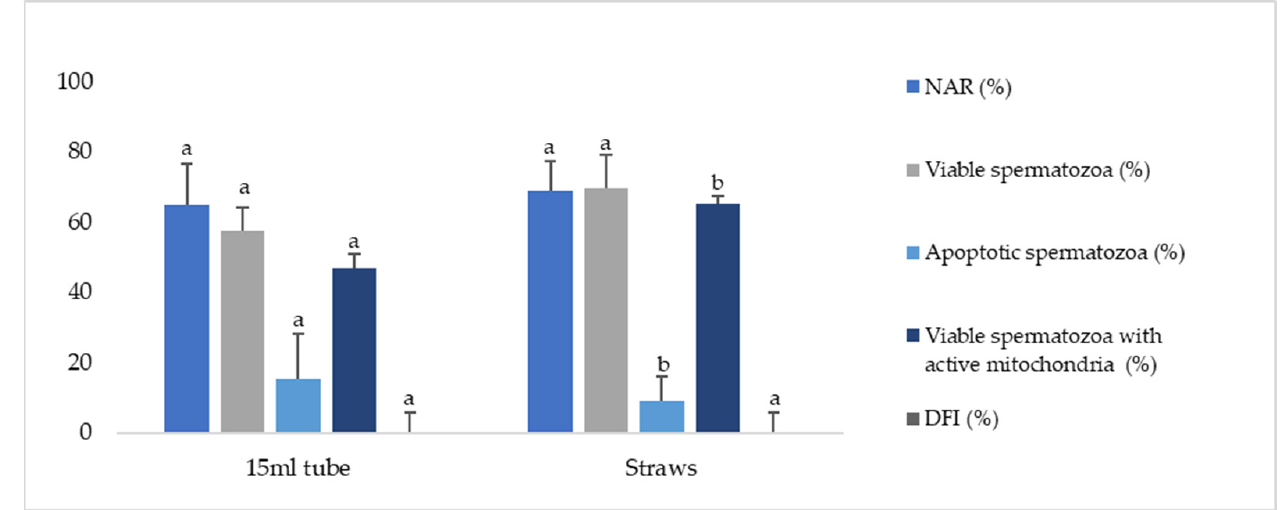
Figure 2. Effects of storage methods during refrigeration of Iberian red deer epididymal sperm samples on spermatozoa quality. Sperm parameters were assessed for two different storage techniques (tubes of 15 mL or 0.25 mL straws) during refrigeration. Data represented as mean ± SEM. NAR— acrosome integrity (%); viable (nonapoptotic) spermatozoa (%); apoptotic spermatozoa (%); viable spermatozoa with active mitochondria (%); DFI—DNA fragmentation index (%). Different letters indicate significant differences between treatments ( p ≤ 0.05).